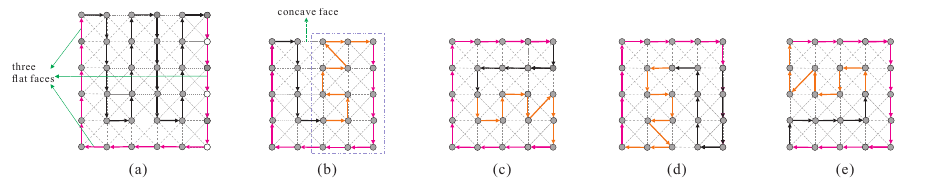
Figure 4. A canonical Hamiltonian cycle containing three flat faces and one concave face for ( a ) R ( 6,6 ) , and ( b – e ) R ( 5,5 ) , where the solid arrow lines indicate the edges in the cycles and R ( 5,5 ) contains four distinct canonical Hamiltonian cycles in ( b – e ) such that their concave faces are placed on different boundaries.